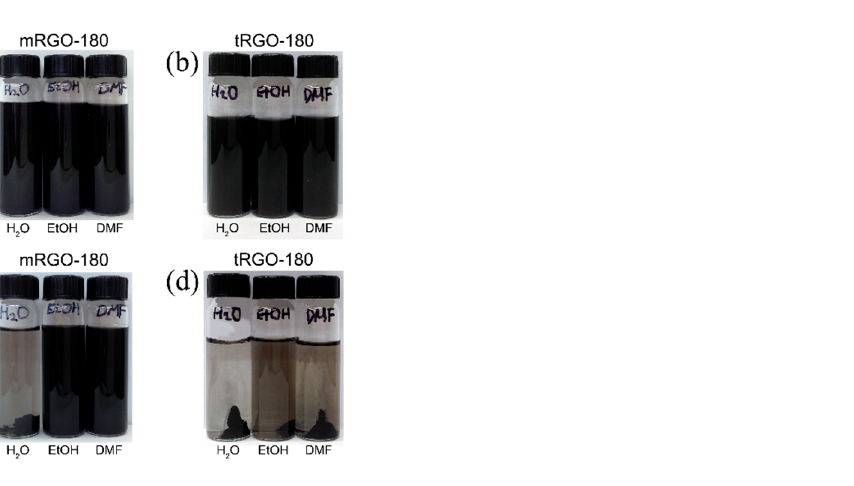
Figure 3. Photographs of ( a ) and ( c ) mRGOs and ( b ) and ( d ) tRGOs dispersion in water, ethanol (EtOH), and dimethylformamide (DMF) ( a ) and ( b ) right after sonication and ( c ) and ( d ) after centrifugation of ( a ) and ( b ) at 4000 rpm for 10 min.